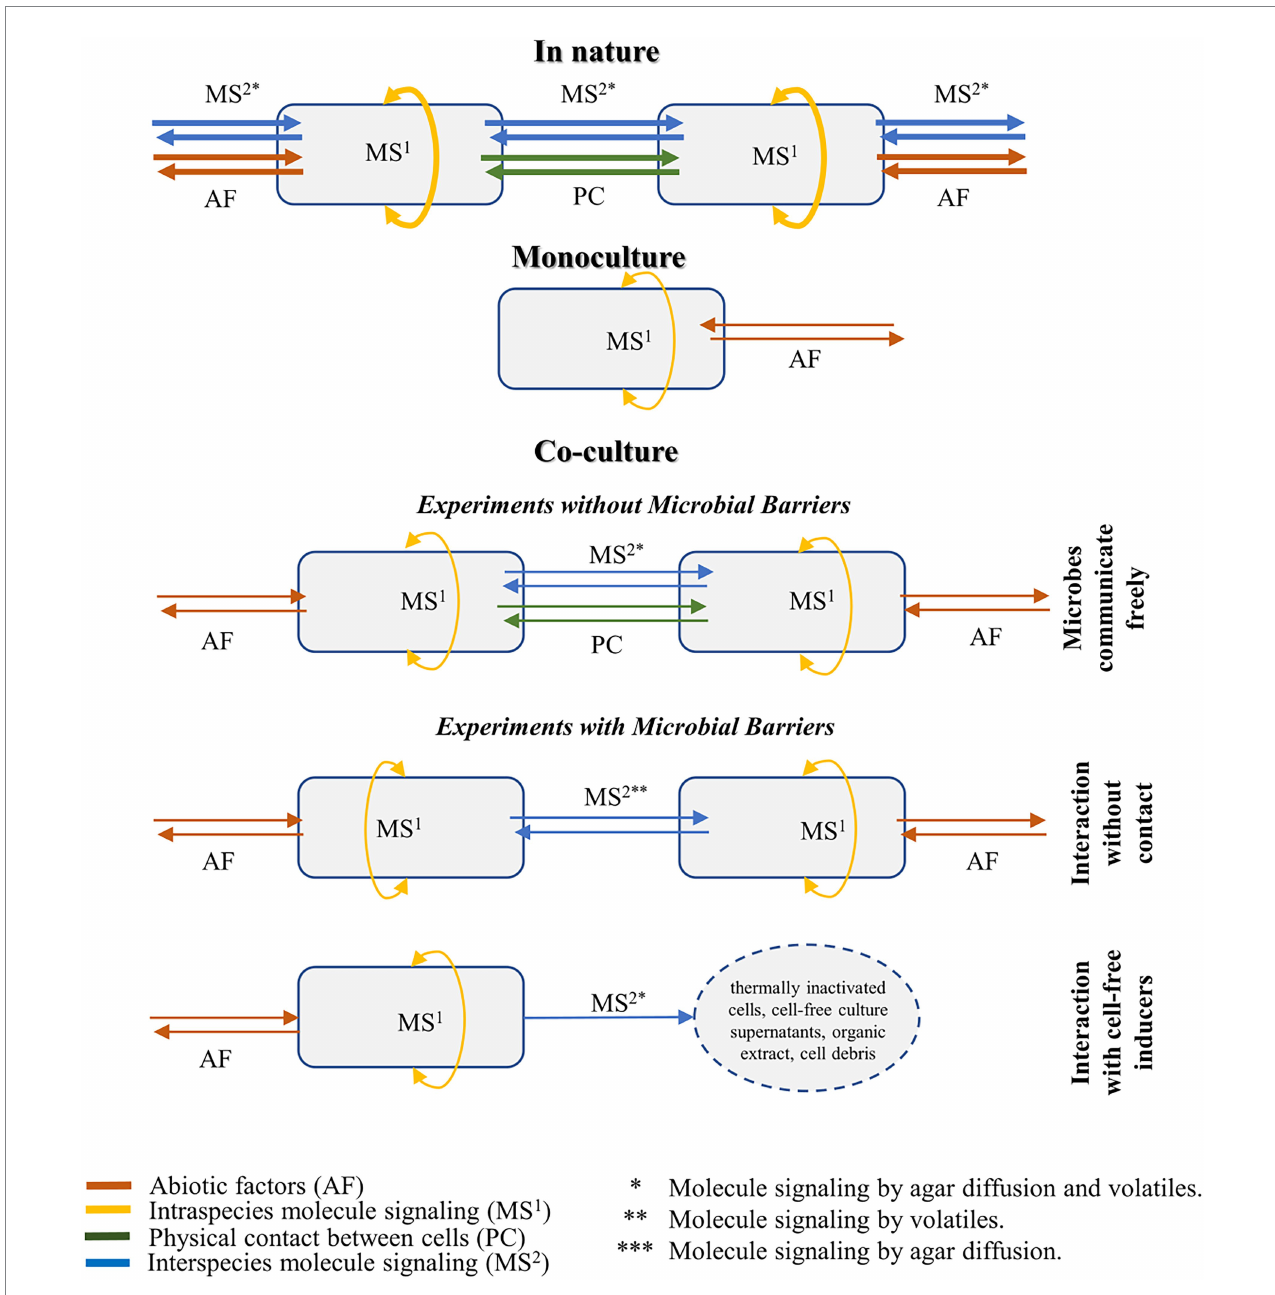
FIGURE 3 Illustration of the microbial interactions and molecule signaling in the natural environment, monoculture, and co-culture settings. Co-cultivation methodologies are divided into three different experimental conditions, considering the degree of contact between the cells and the type of induction evaluated in the